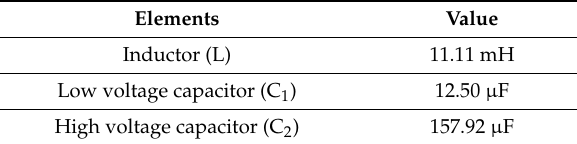
Table 2. Passive elements.